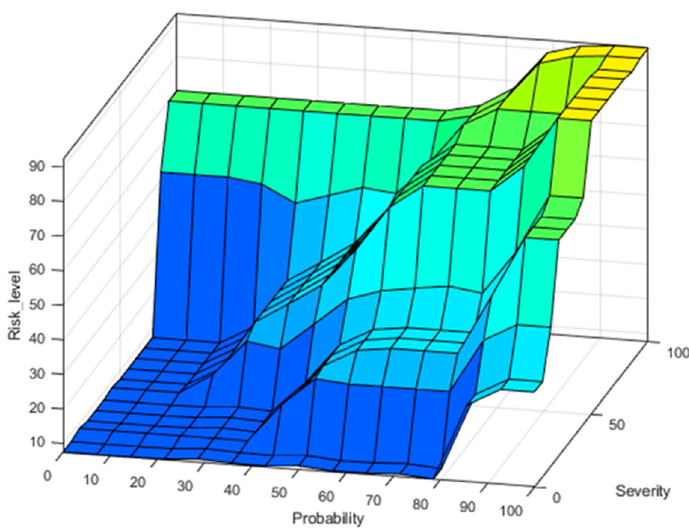
Figure 6. Risk level surface with respect to Probability and Severity membership functions.